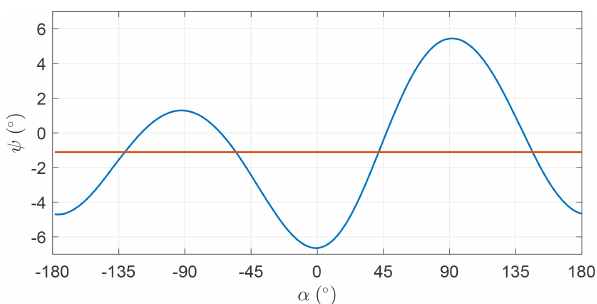
Figure 17. Optimal ψ (blue line) and its mean (red line) as a func- tion of the angular position.